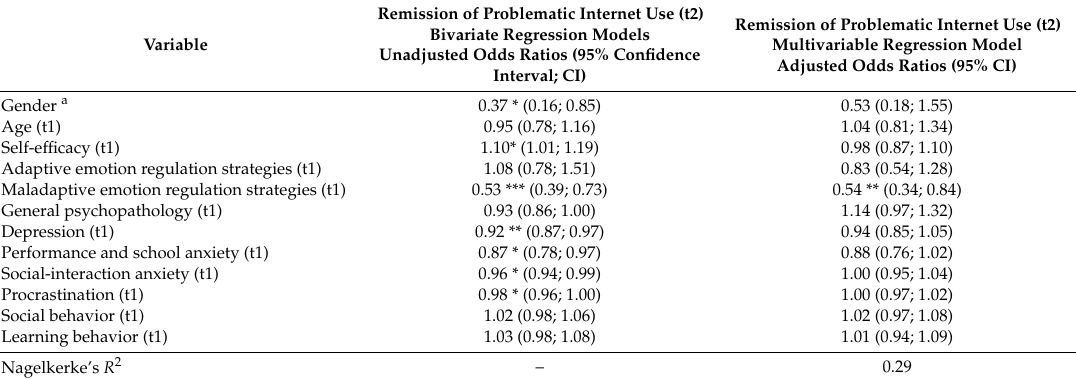
Table 2. Bivariate and multivariable logistic regression analyses concerning predictors of spontaneous remission of problematic Internet